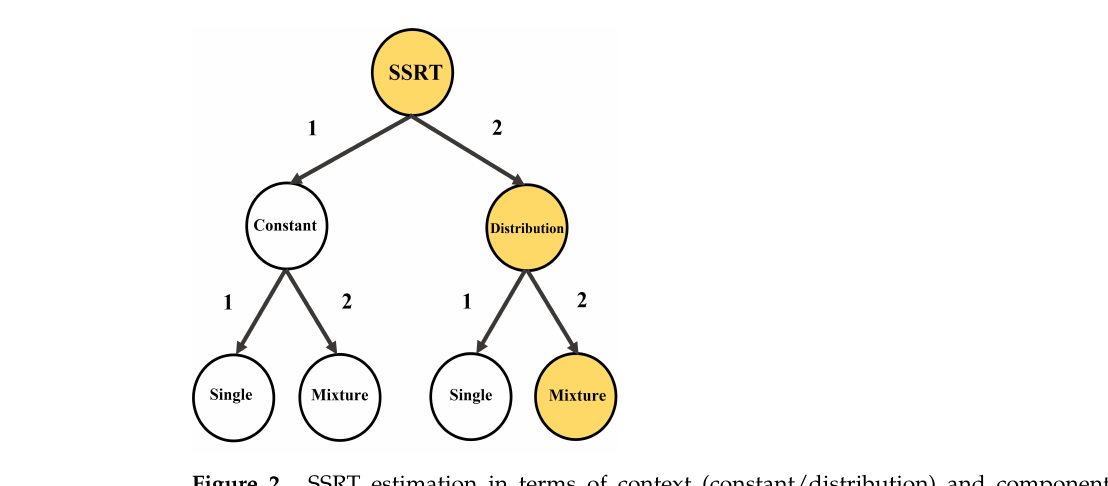
Figure 2. SSRT estimation in terms of context (constant/distribution) and components (sin- gle/mixture): current literature (path 1-1,1-2,2-1); this study (path